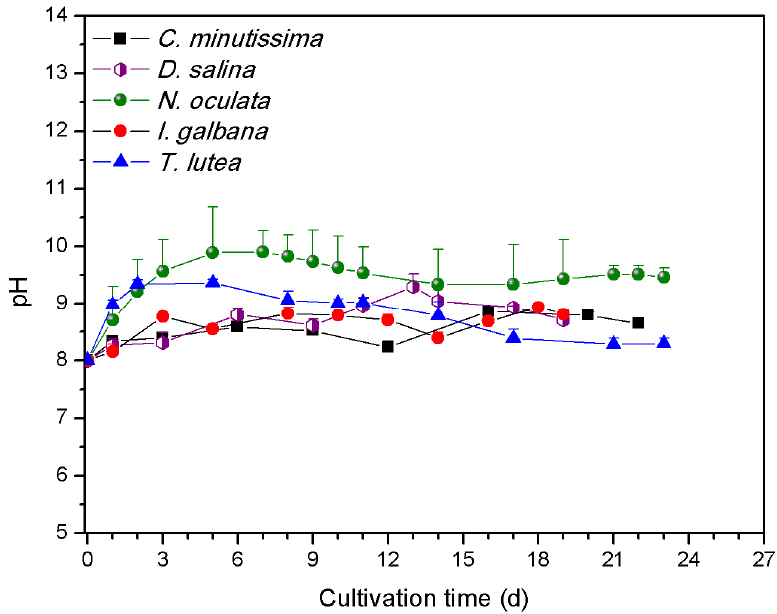
Figure 2. pH values upon cultivation of the marine microalgal species C. minutissima , D. salina , N. oculata, I. galbana , and T. lutea. Table 1. Nutrient consumption, pH, final OD 750 , final TSS, and μ max ± the standard deviation.